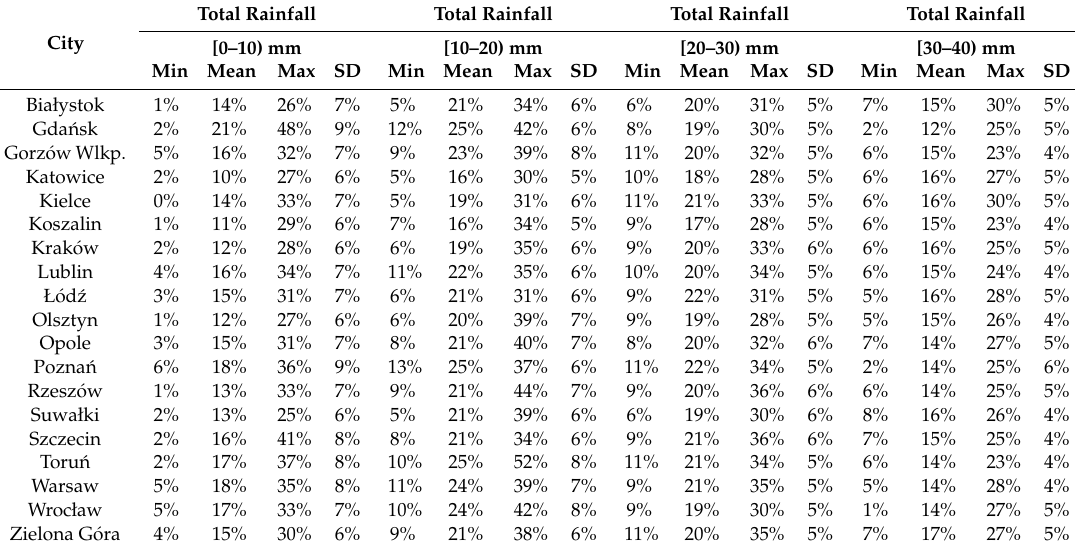
Table 3. Twenty-day cumulative rainfall for the analysed intervals—percentage share in the